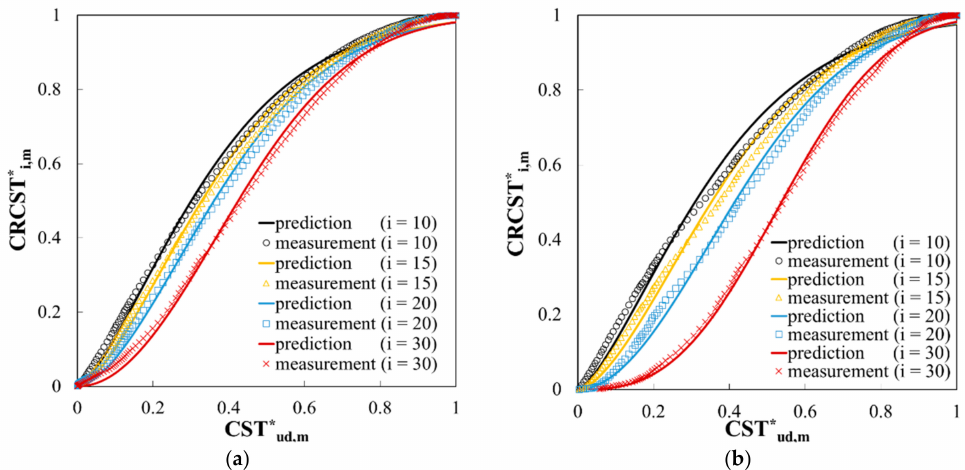
Figure 7. CRCST * i,m and CST * ud,m curves for the ( a ) site A and ( b ) site